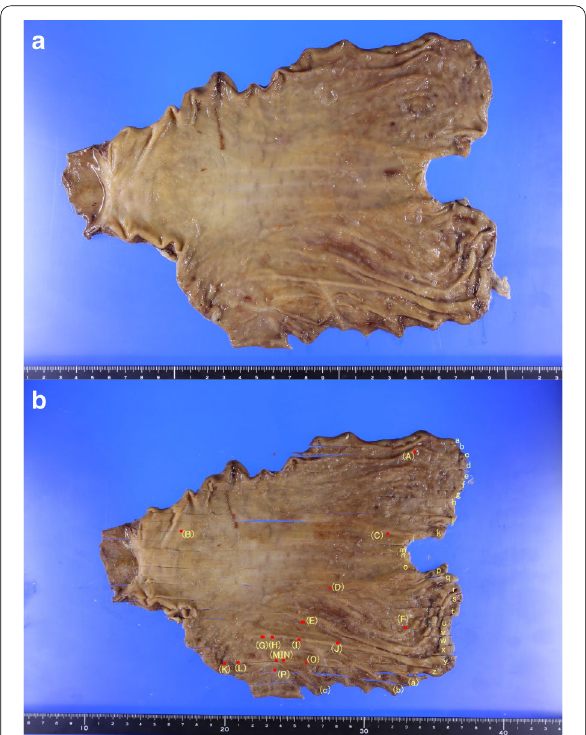
Fig. 3 Macroscopic image of the resected specimen. a Original formalin-fixed specimen. b Mapping of multiple lesions on the gastric body. Sixteen individual sporadic lesions were